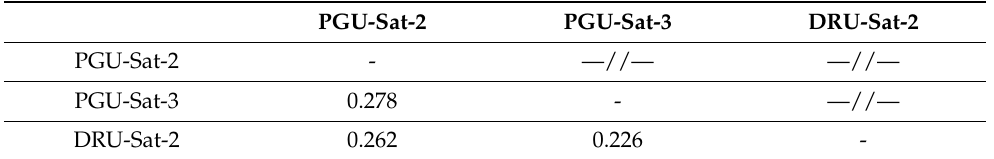
Table 3. The p-distances between the consensus sequences of the PGU-Sat-2/PGU-Sat-3/DRU-Sat- 2